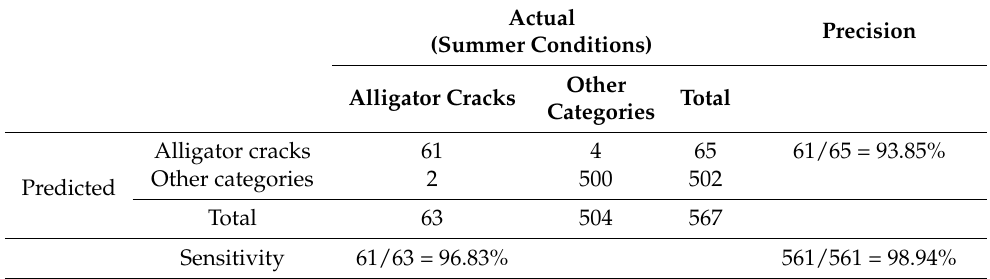
Table 4. Confusion matrix—2 variables (DC alligator used for instance).